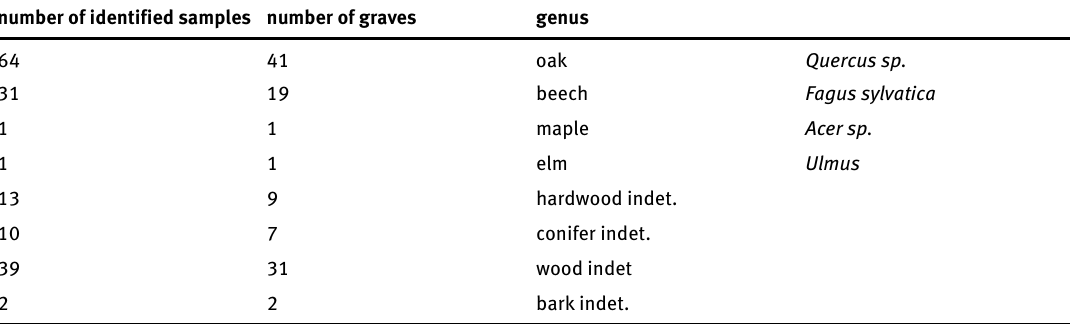
number of identified samples number of graves